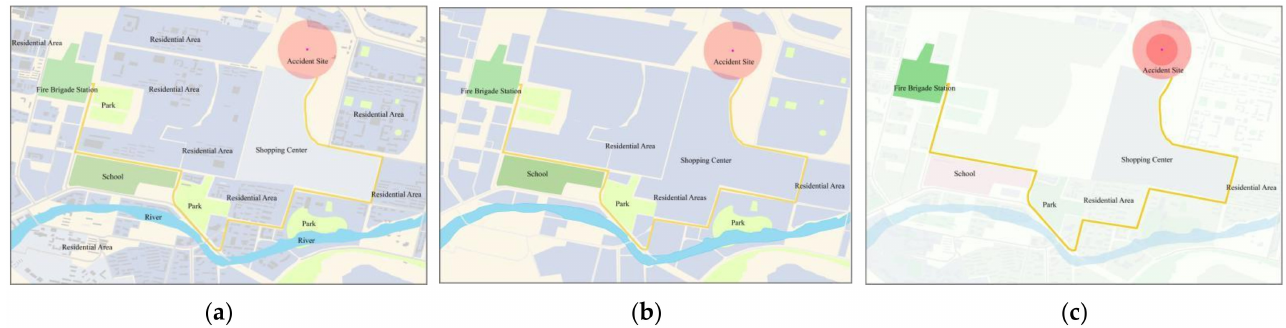
Figure 4. Three different fire emergency rescue road maps: ( a ) non-relevance filtered and non-saliency map; ( b ) relevance filtered but non-saliency map; and ( c ) relevance filtered and saliency